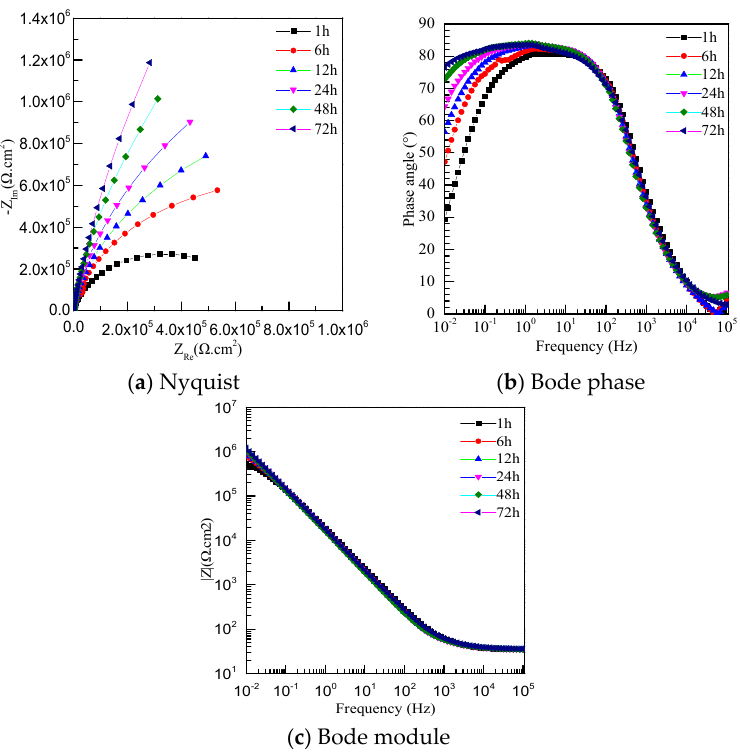
Figure 6. EIS spectra of J P measured at OCP after different immersion times in 1 M NaCl solution.